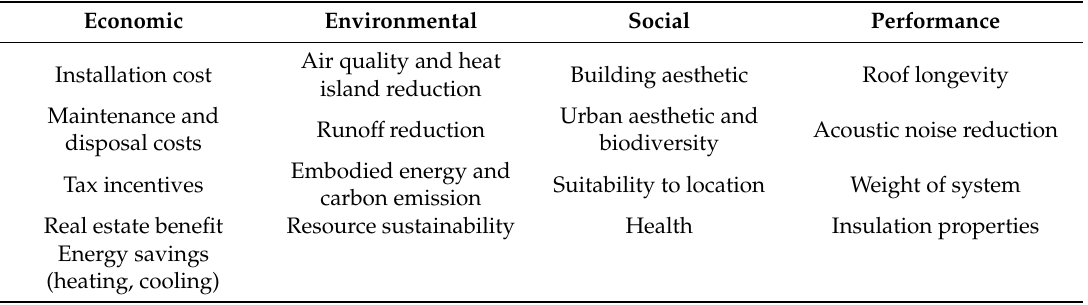
Table 2. The 4 groups of criteria and the 17